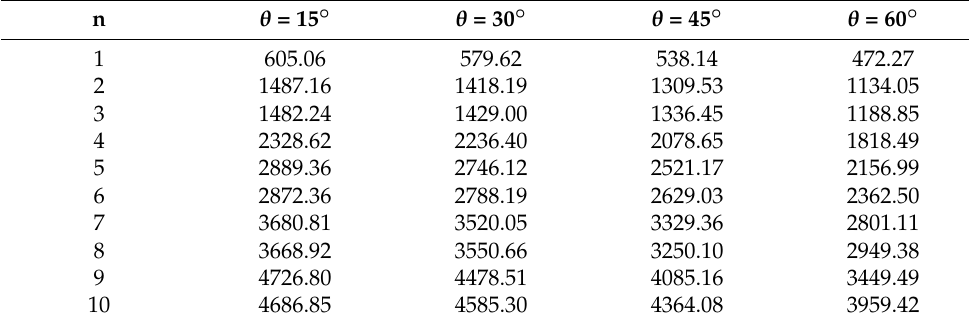
Table 5. Frequencies of ZPR honeycomb plate with angle θ